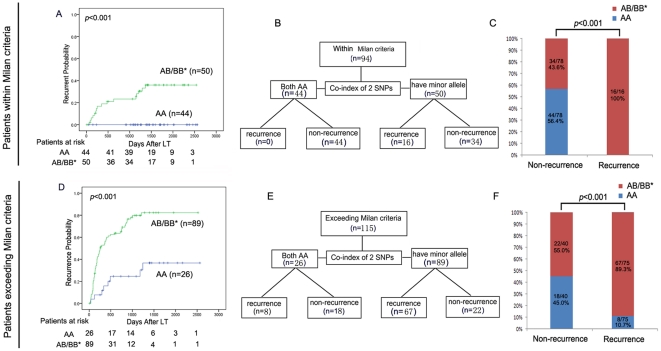
The relationship of the co-index (rs894151/rs12438080) in patients within Milan criteria (upper panel) and exceeding Milan criteria (lower panel).Time to recurrence of the co-index (rs894151/rs12438080) in patients within Milan criteria (A) and exceeding Milan criteria (D). The prognostic significance was assessed using Kaplan-Meier survival estimates and log-rank tests. B, E, The recurrences in patients with AA at both SNPs were 0/44 (within Milan criteria) and 8/26 (exceeding Milan criteria). In patients with a minor allele, the recurrences were 16/50 (within Milan criteria) and 67/89 (exceeding Milan criteria). C, F, Frequency distributions of genotypes in non-recurrence and recurrence patients. The p-value was calculated by chi-square test.